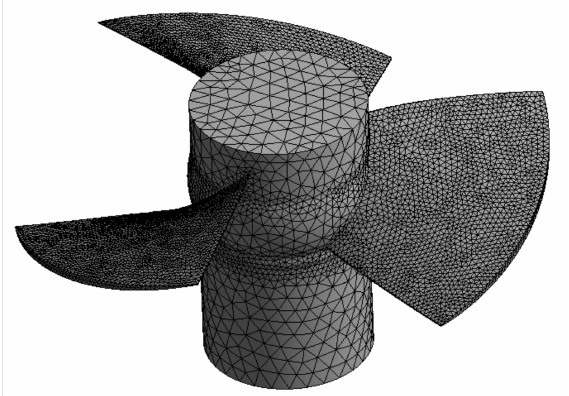
Figure 5. The finite element mesh of the